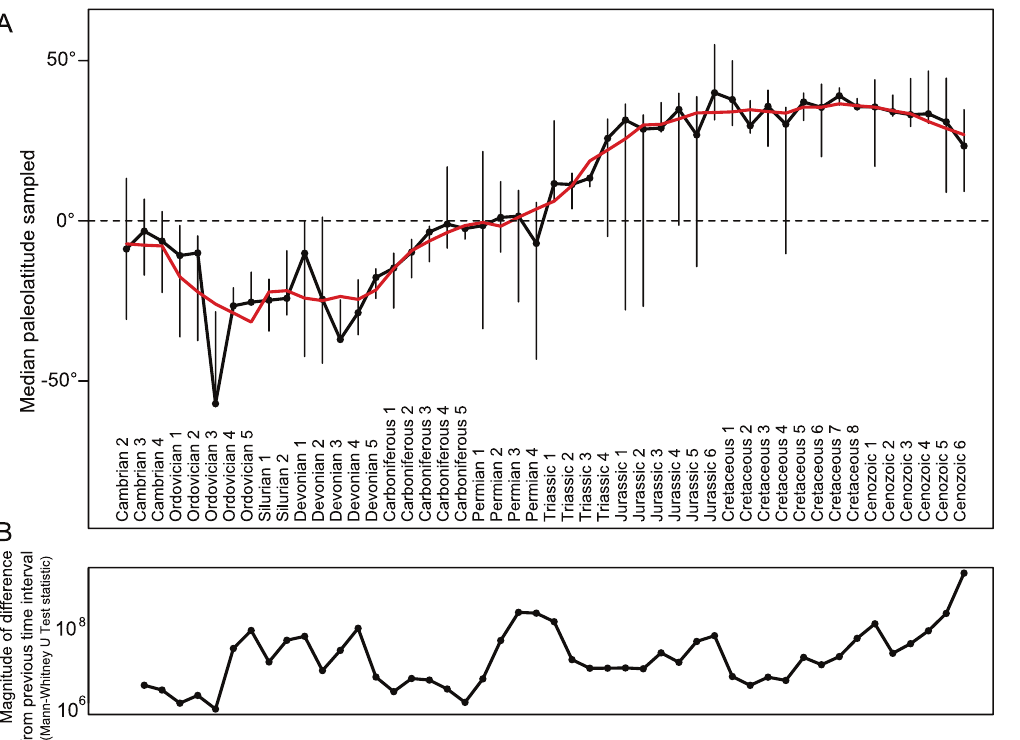
Figure 3. Spatial shifts in fossil occurrences through the Phanerozoic. A) The median latitude of fossil occurrences steadily rises through the Phanerozoic, but is punctuated by short-term noise and contractions and expansions of geographic coverage. Error bars indicate 25th and 75th quantiles, while the red line is a moving average across five points. B) The Mann-Whitney U test statistic plotted for each interval. A higher test- statistic corresponds to a more severe change in latitude. All transitions are statistically significant but vary in their effect size.